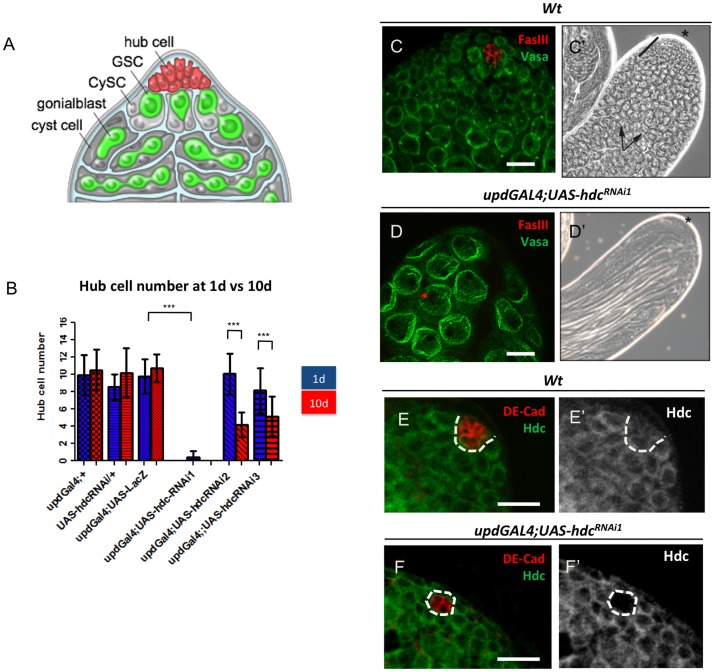

hdc function is required to maintain hub cells in the Drosophila testis.(A) Schematic of the male germline stem cell niche. (B) Hub cell quantification at 1d(blue) and 10d(red) in controls and upon reduction of hdc. N = 30 for each genotype/time point. Mean and SD are shown; ***P<0.001 (Kruskal–Wallis one-way analysis of variance). (C) Immunofluorescence image of wild-type (wt) testis. FasIII (hub, red), Vasa (germ line, green) (C’) Phase-contrast image of a wt testis. Asterisk denotes apical tip; transit-amplifying spermatogonia (black bar); spermatocytes (arrows). (D and D’) Reduction of hdc in hub cells leads to loss of hub cells and niche degeneration. Note absence of FasIII+ hub cells (red) and presence of large spermatocytes or mature sperm (D’) at the apical tip. (E and E’) Testis from wt larval (L3) male gonad showing Hdc expression in all cells at the apical tip. (F and F’) RNAi-mediated knock-down of hdc in hub cells results in loss of Hdc protein. Similar results were obtained for all RNAi lines tested. Scale bars, 20 µm. See also Table 1 and Figure 2.